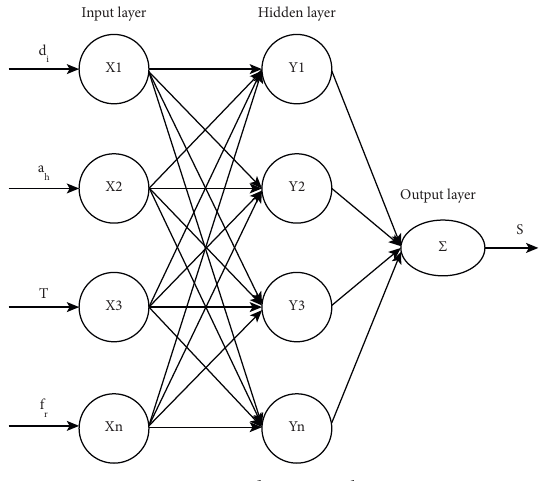
Figure 8: Prediction with